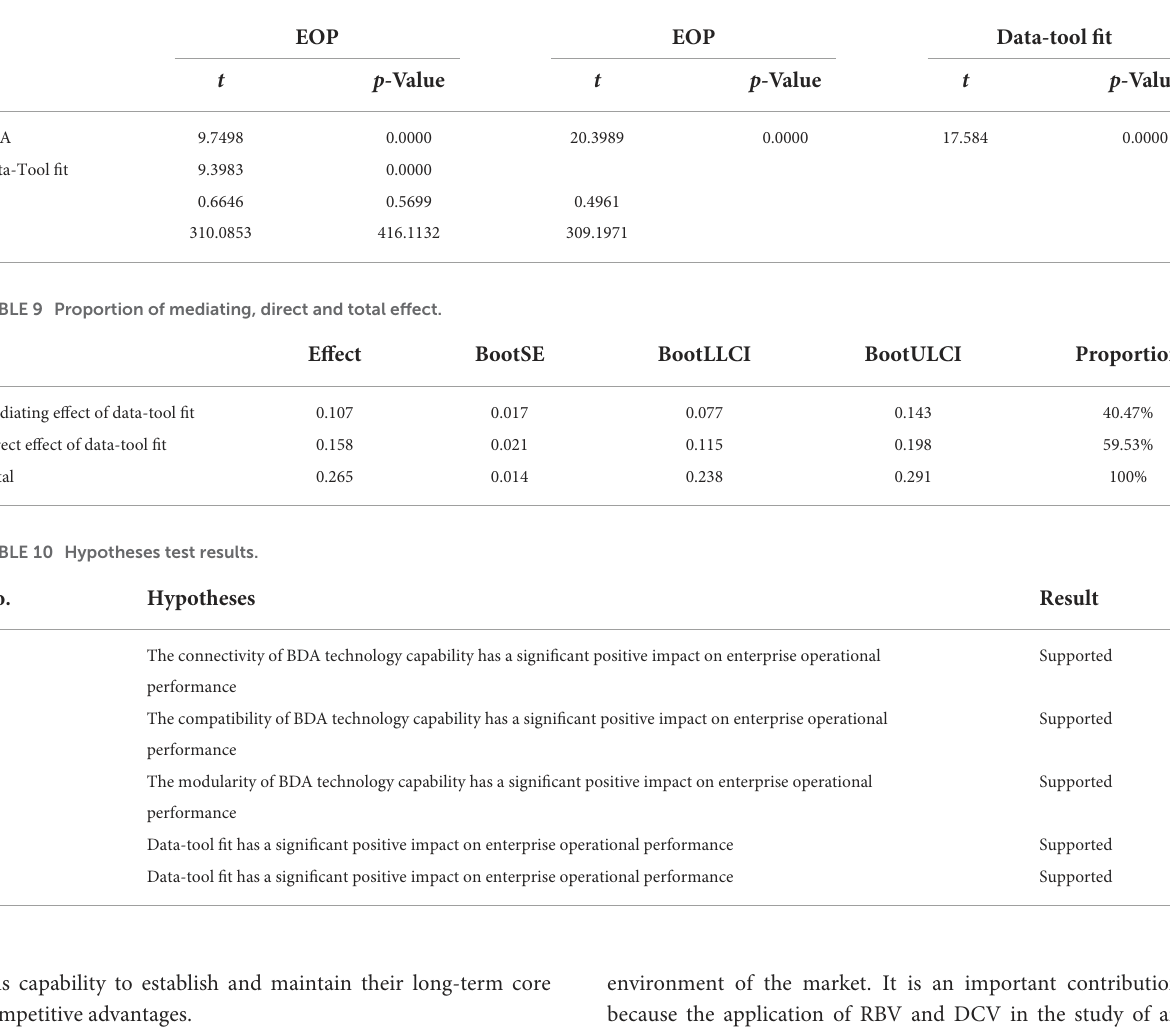
TABLE 8 Mediation model validation for data-tool fit.